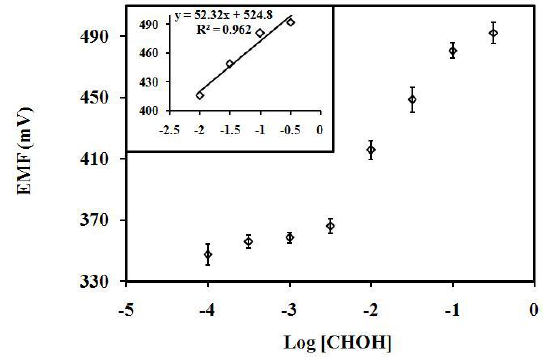
Figure 7. The response of a formaldehyde biosensor fabricated from poly(HEMA) film as an enzyme immobilization matrix towards various concentrations of formaldehyde in 10 mM Tris-HCl buffer at pH 6.5.